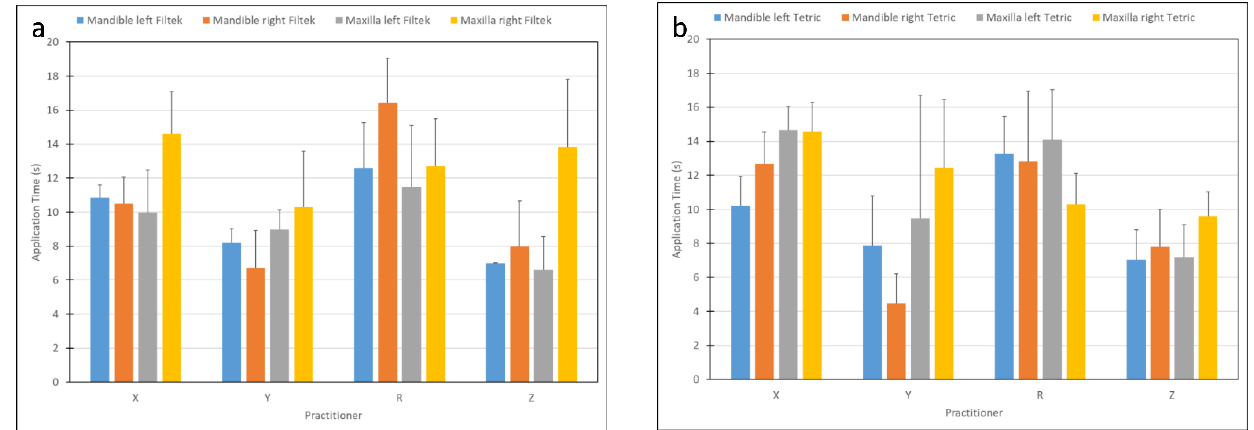
Figure 4. Restoration placement application time as related to practitioner and materials: ( a ) Filtek, ( b ) Tetric.